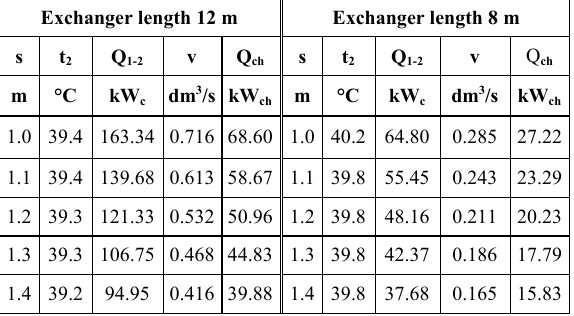
Table 1. Evaluation results for the exchanger with length of l = 12 m and l = 8